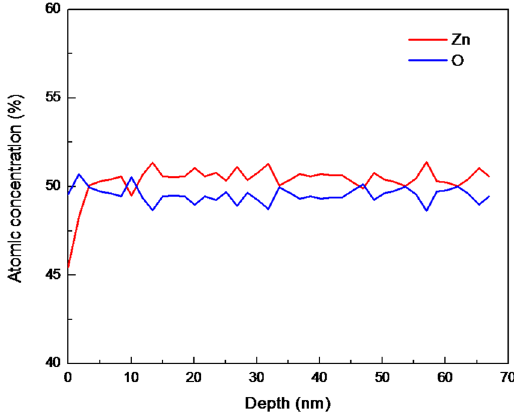
Figure 2. Auger electron spectroscopy (AES) depth profile spectra of an as-grown CVT ZnO crystal.